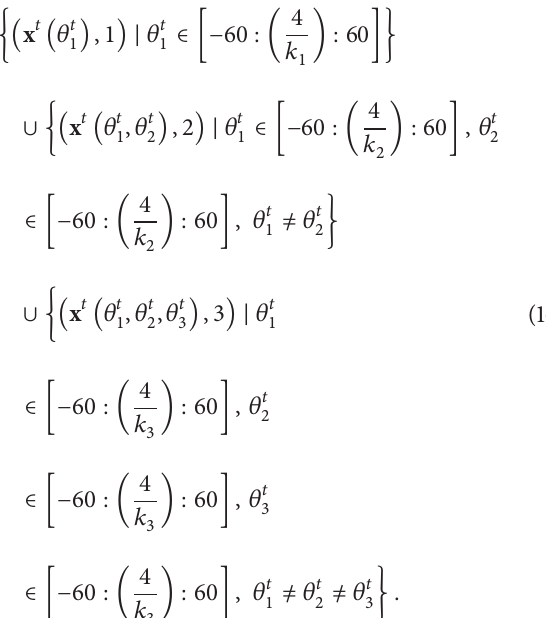
Table 1: The parameters used for training and testing. Frequency 𝑓 = 7.5 GHz Maximal number of sources 𝑆 = 3 Number of antenna array elements per one source Mutual distance of the antenna array elements 𝑑 = 𝜆/2 (0.02 m) Sampling points distance from source trajectory Number of sampling points 𝑀 = 6 Mutual distance of the sampling points 𝑠 𝑑 = 𝜆/2 (0.02